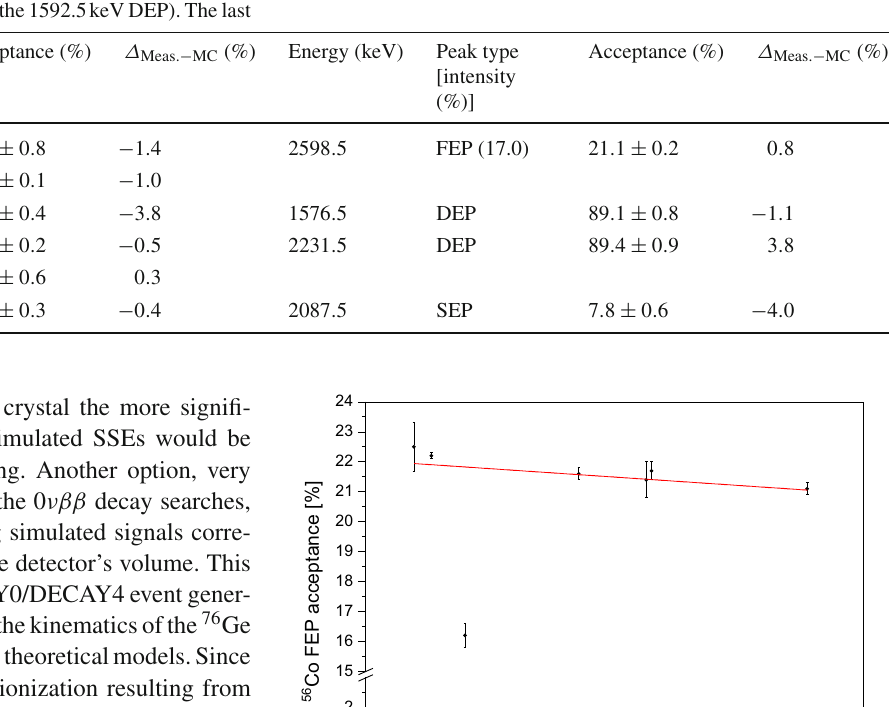
column contains differences in acceptance between the simulated and measured data (Table 2)